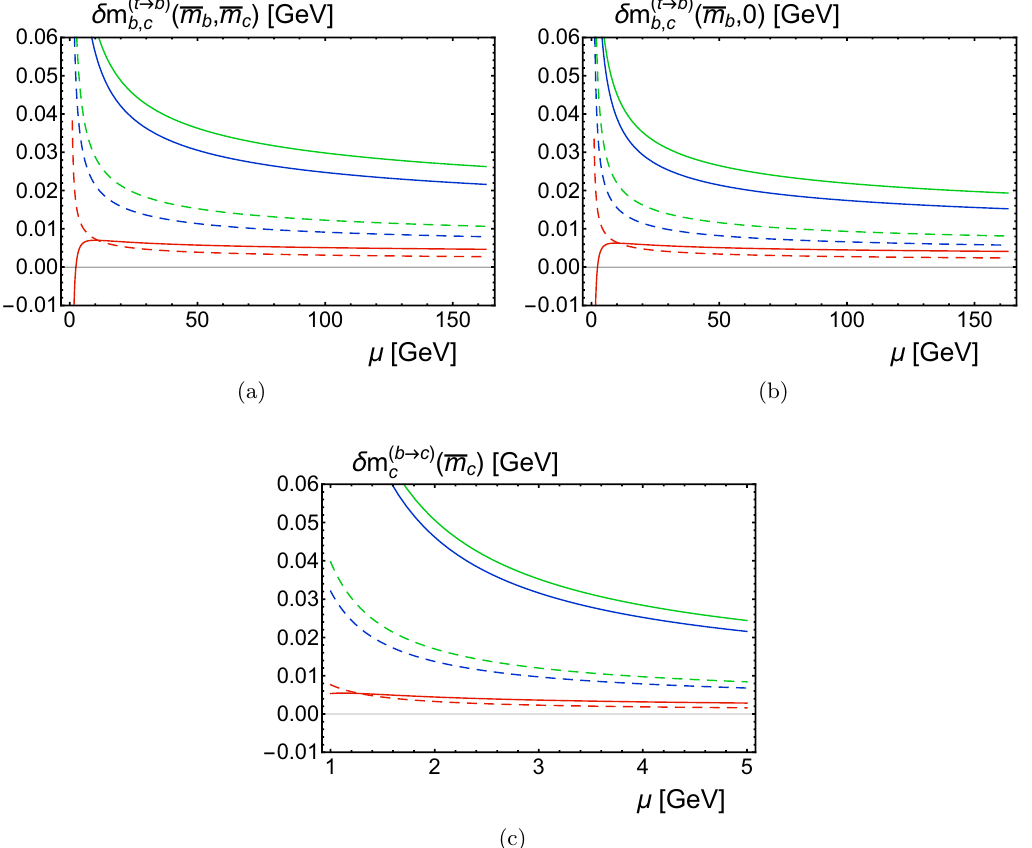
Figure 3 . (a) Top-MSR bottom-MS mass matching correction (cid:14)m ( t ! b ) ( m b ; m c ) at O ( (cid:11) 2 ) (red s b;c dashed curve) and O ( (cid:11) 3 ) (red solid curve) over the renormalization scale (cid:22) . The virtual bottom s and charm mass e(cid:11)ects to the top quark self energy of eq. (3.6) (green curves) and the virtual bottom and charm mass e(cid:11)ects to the bottom quark self energy of eq. (3.7) (blue curves) at O ( (cid:11) 2 ) (dashed) s and O ( (cid:11) 3 ) (solid). For the masses of the top, bottom and charm quarks the values ( m t ; m b ; m c ) = s (163 ; 4 : 2 ; 1 : 3) GeV are used. (b) Same quantities as in panel (a) for m c = 0. (c) The bottom-MSR ( m c ) at O ( (cid:11) 2 ) (red dashed curve) and O ( (cid:11) 3 ) s s